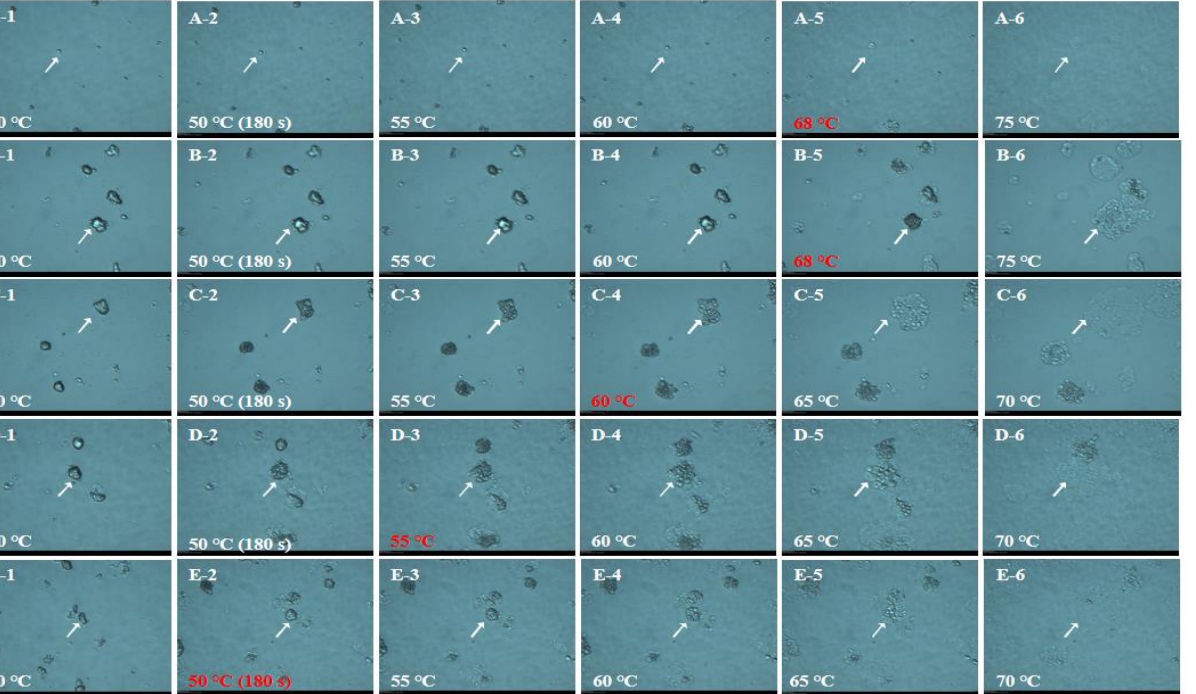
Figure 3. The dynamic gelatinzation process of JWR. “A − 1–A − 6”, “B − 1–B − 6”, “C − 1–C − 6”, “D − 1–D − 6” and “E − 1–E − 6” stand for the dynamic gelatinzation process of JWR − W, JWR − D − 60, JWR − D − 120, JWR − D − 200 and JWR − D − 320, respectively. The temperature represents the swelling temperature of the sample.